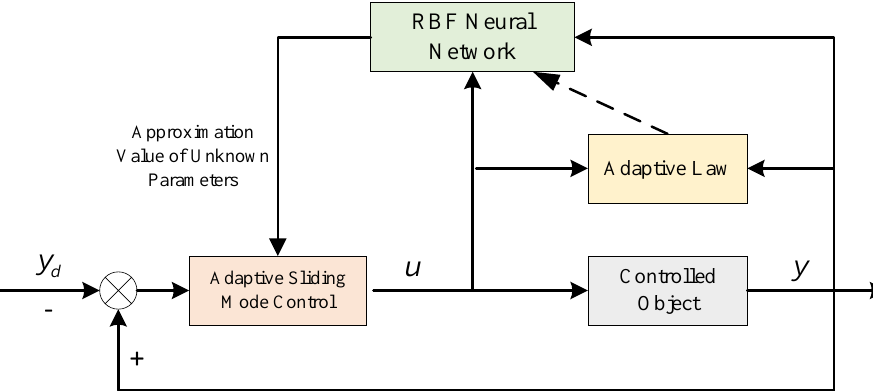
Figure 4. Adaptive sliding mode control based on RBF neural network.